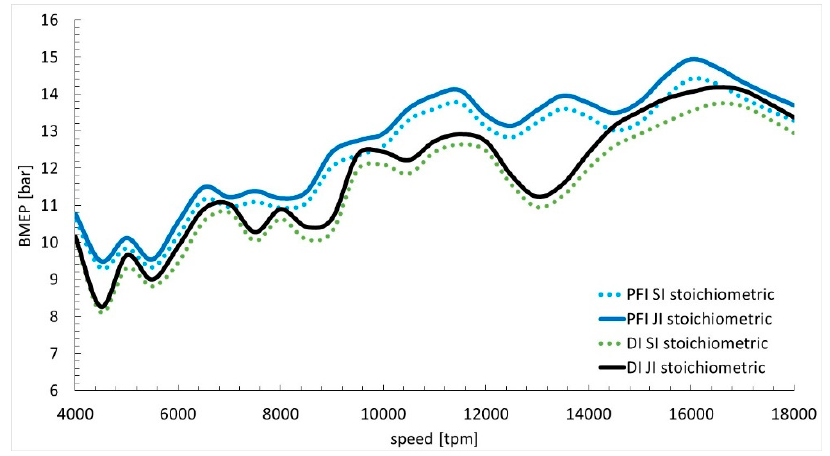
Figure 2. Brake mean effective pressure (BMEP) of stoichiometric engines.